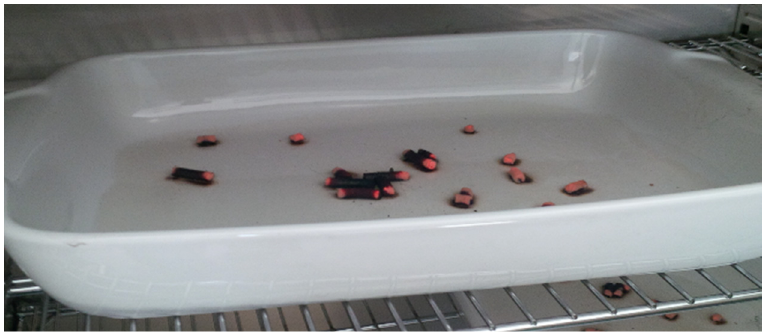
Figure 14. Torrefied biomass pellets submitted to a temperature of approximately 95 °C.